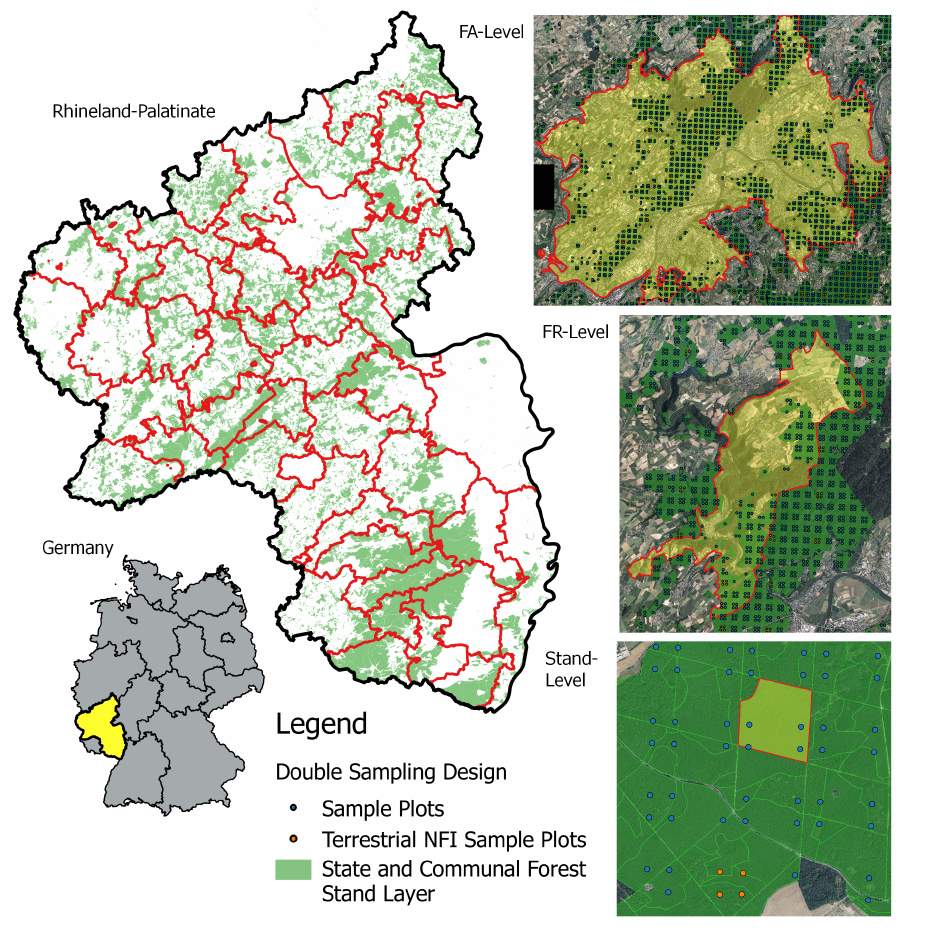
Figure 1. ( Left ): Study area with delineated FA forest management units. ( Right ): Example for each of the three management units (from top to bottom): FA, FR and forest stand unit overlayed with the extended double-sampling cluster design. Green: Forest stand polygon layer defining the state and municipal forest area of this